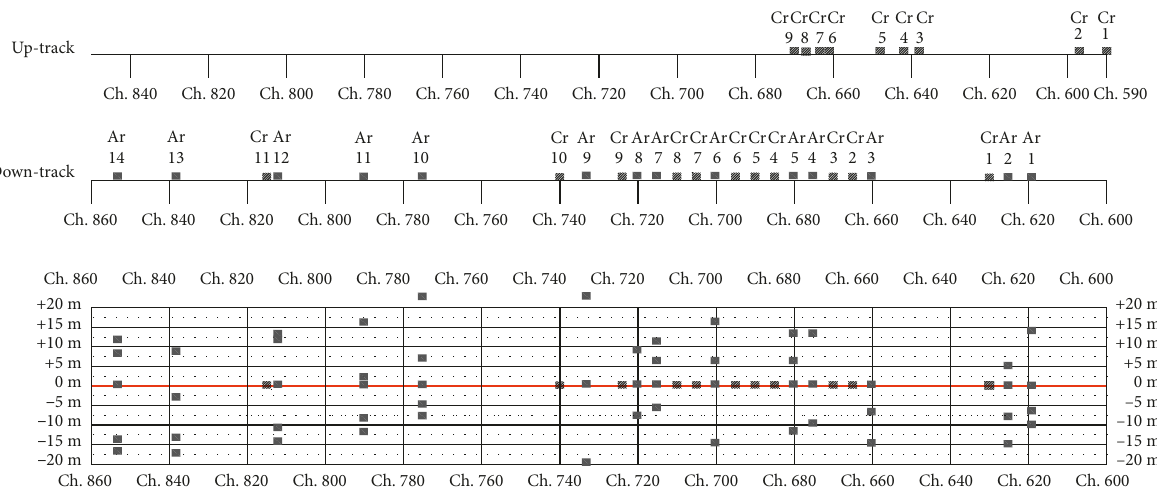
Figure 3: Instrumentation for ground settlement